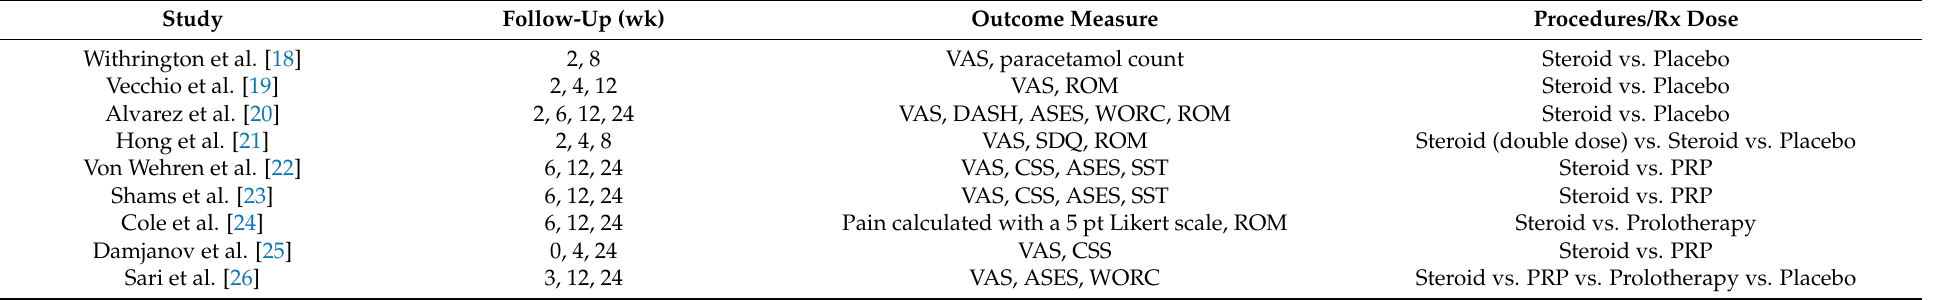
Cole et al. [24] Damjanov et al.